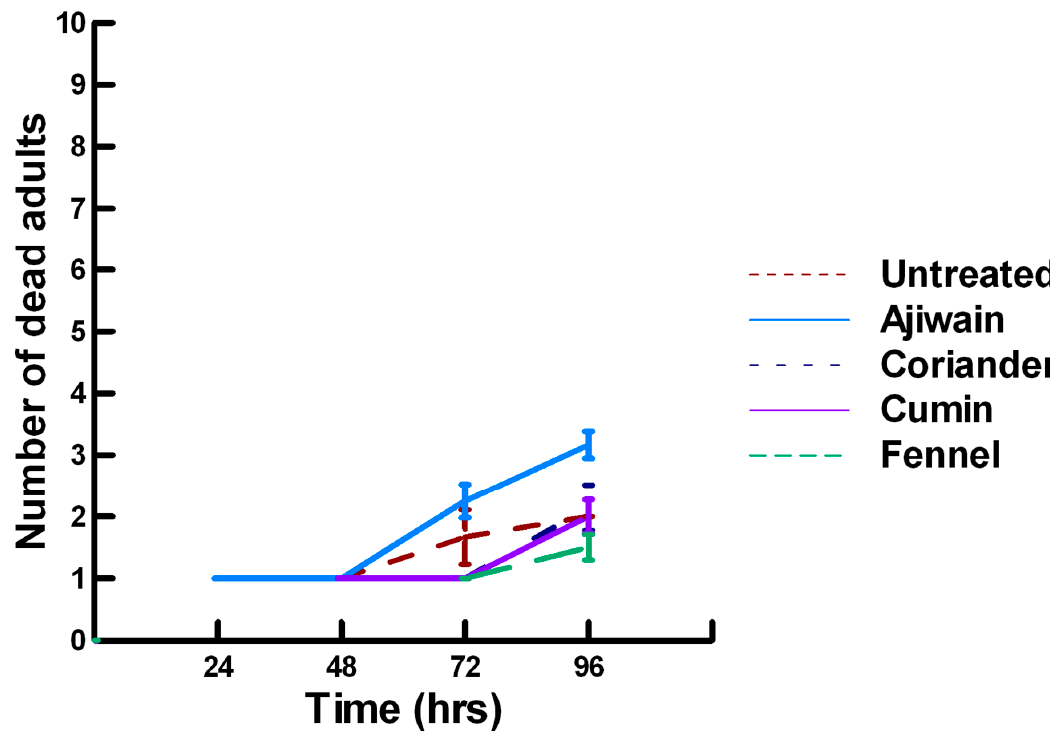
Figure 9. Acute contact toxicity with a low concentration of plant powders from the family Apiaceae (Ajwain, coriander, cumin and fennel) adherent to male adult Megachile rotundata (ALBs). Means and standard error shown.